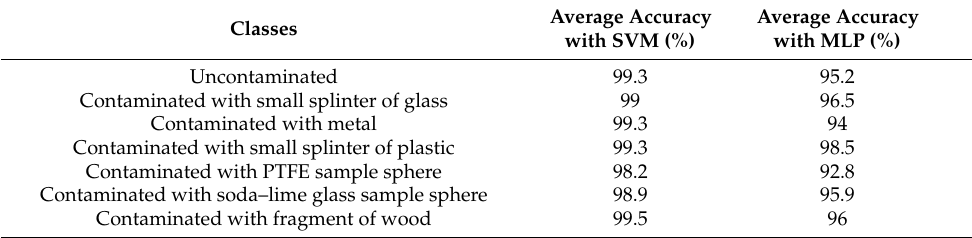
Figure 10. The plot of the misclassified terms FP and FN of the confusion matrices for each contami- nated class alone. The results obtained by the MLP algorithm trained on the Magnitude only dataset. Table 4. The average performance accuracy of the two classifiers with the Magnitude only dataset.